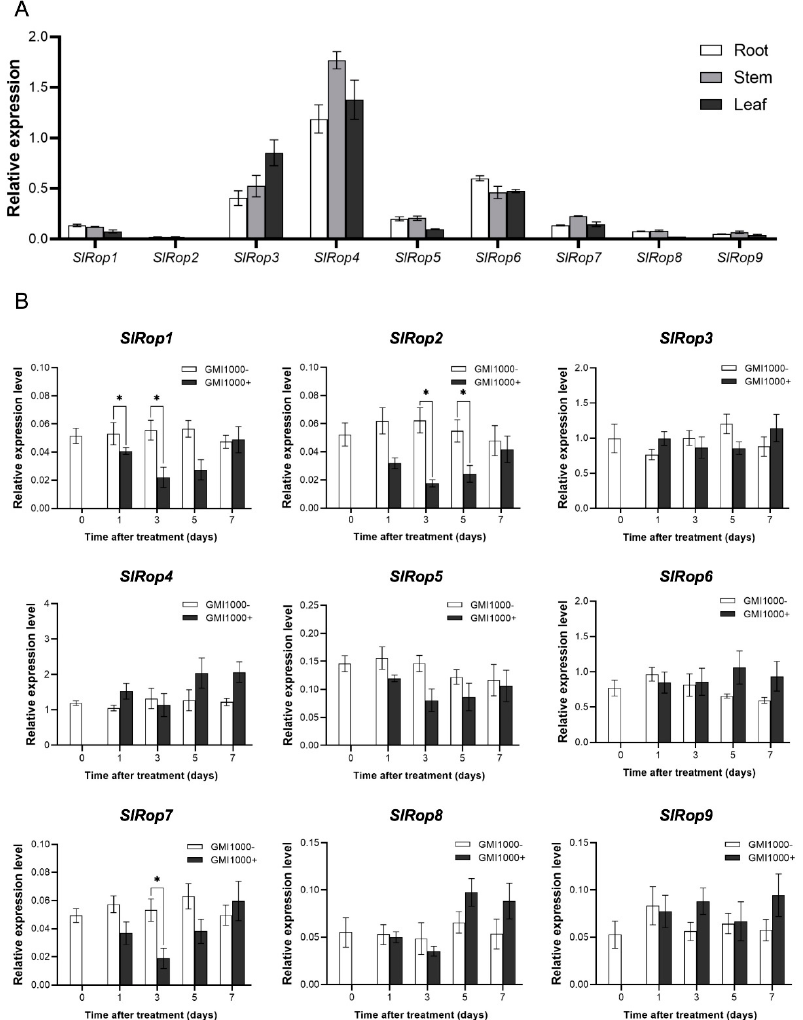
Figure 6. Transcript levels of SlRop1 – 9 in different tissues and upon R. solanacearum infection. ( A ), Natural tissue-specific expression of Rho-like small GTPases in tomato. Total mRNAs were extracted from the roots, stems, and leaves of tomato seedlings. qRT-PCR was performed with specific primers for SlRop1 – 9 and ubiquitin . The relative expression levels of SlRops were calculated using ubiquitin as the internal reference gene. Data are represented as the means ± SD. Three independent experiments were conducted. ( B ), The relative transcriptions of nine genes from tomato after infection with R. solanacearum . The cDNAs from whole tomato seedlings treated with the R. solanacearum GMI1000 strain at different time points (1, 3, 5, and 7 d) were used as templates for SlRop1 – 9 amplification. Water treatment was used as the negative control. Ubiquitin was selected as the internal reference for analyzing the relative expression levels of target genes. Data are expressed as the means ± SD (one-way ANOVA; * p < 0.05; n =